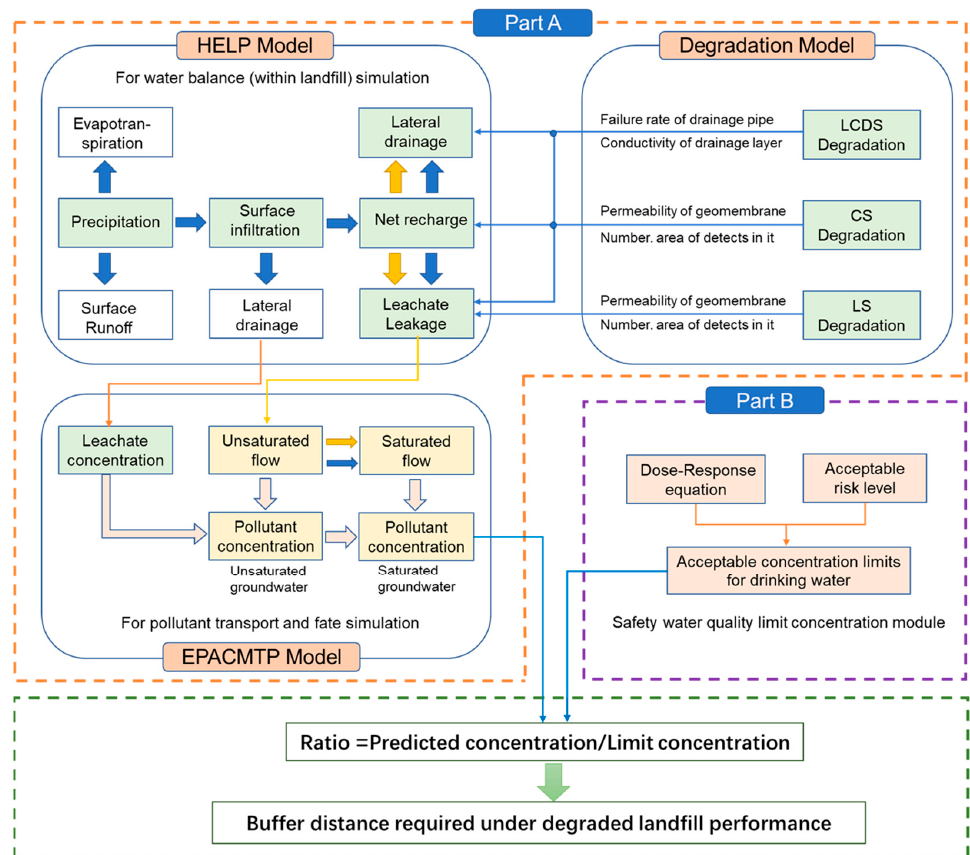
Figure 1. Framework and process of BFD for hazardous waste landfills under long-term aging conditions.